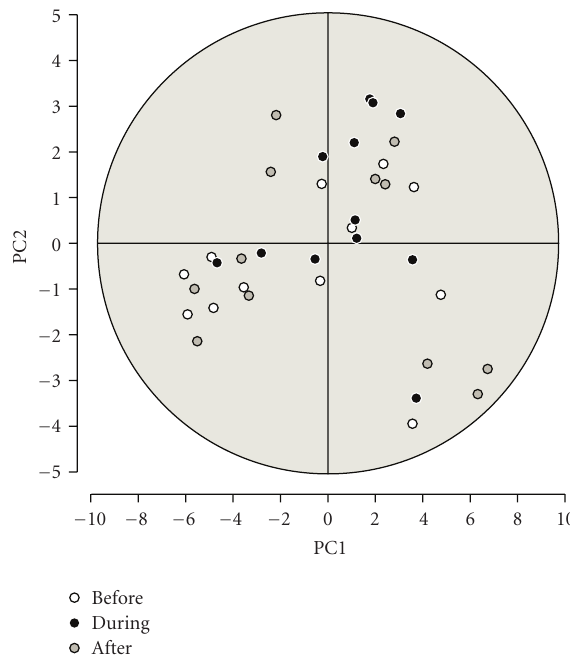
Figure 4: Principal component analysis of “before” “during,” and “after-treatment” spot maps. No clustering of spot maps can be observed for any if the 3 conditions.